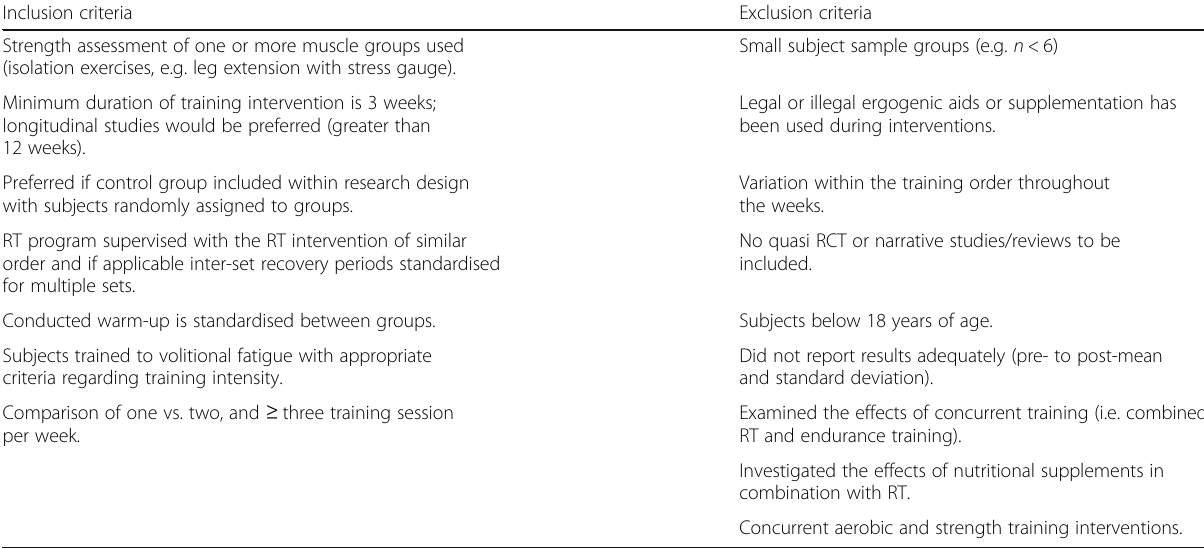
Table 1 Inclusion and exclusion criteria Inclusion criteria Exclusion criteria